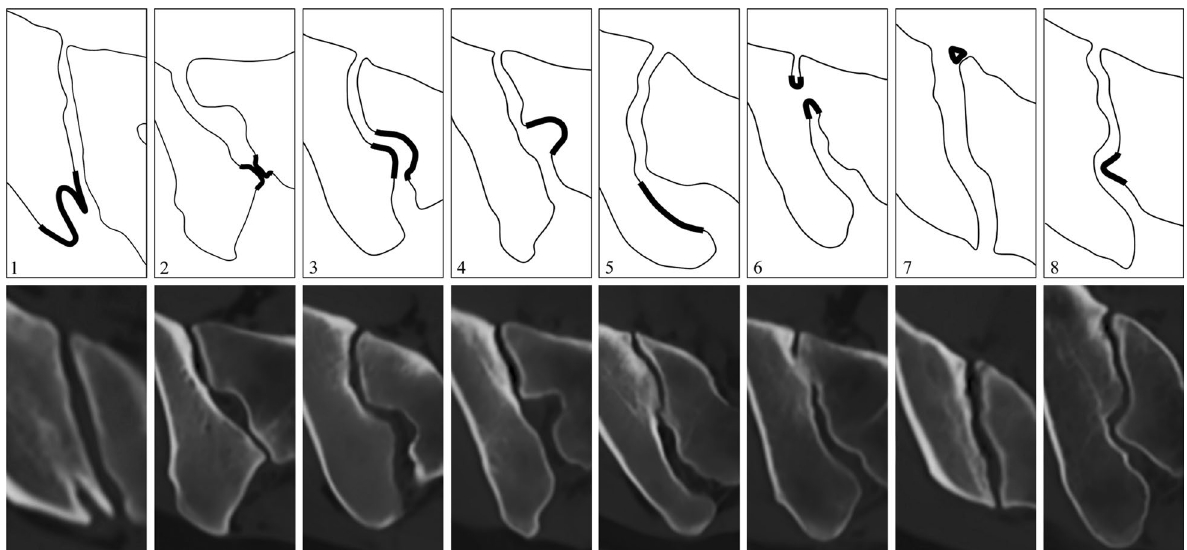
Fig. 2 Schematic drawing and corresponding synthetic CT images of sacroiliac joint (SIJ) variations, all shown in semi-axial plane: (1) bipartite iliac bony plate, (2) accessory SIJ, (3) iliosacral complex, (4) semicircular defect, (5) crescent ilium, (6) isolated synostosis, (7) unfused ossification center, and (8) dysmorphic